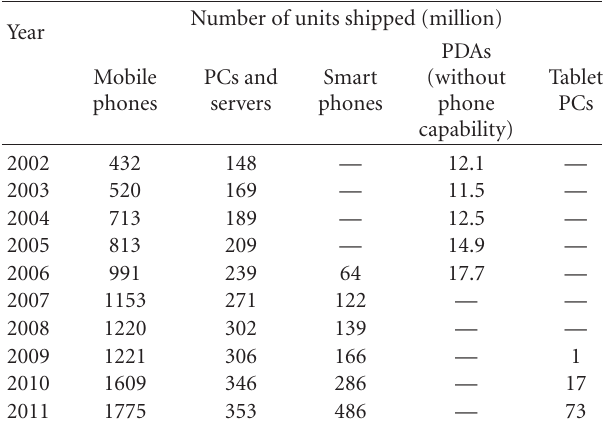
Figure 1: A system structure of generic location-based services. Table 1: Worldwide PC, cellphone, and tablet PC